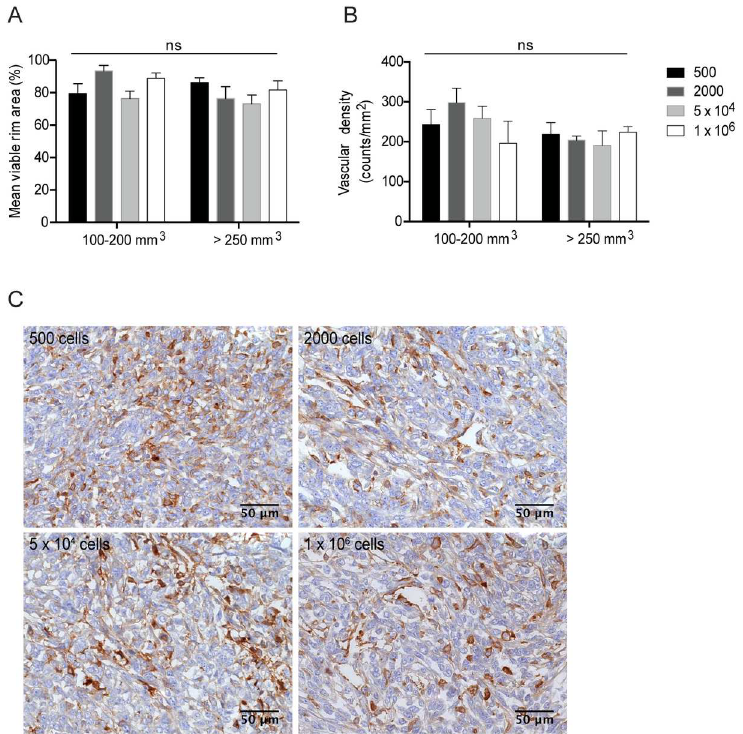
Fig 3. Effect of cell density and tumor mean volume on viable rim area and vascular density. Quantitative analysisof viable rim area (A) and vascular density (B) was assessed in tumors with mean volumes of 100–200mm 3 and > 250 mm 3 , based on H&E or CD31 immunostaining in carcinoma sections derivedfrom 500, 2000, 5 x 10 4 and 1 x 10 6 cancer cells, originalmagnificationx400 (C). Data represent the mean ± SEM of 3–6 independent sections. ns, p > 0.05 two-way ANOVA with Tukey’s multiple comparisons